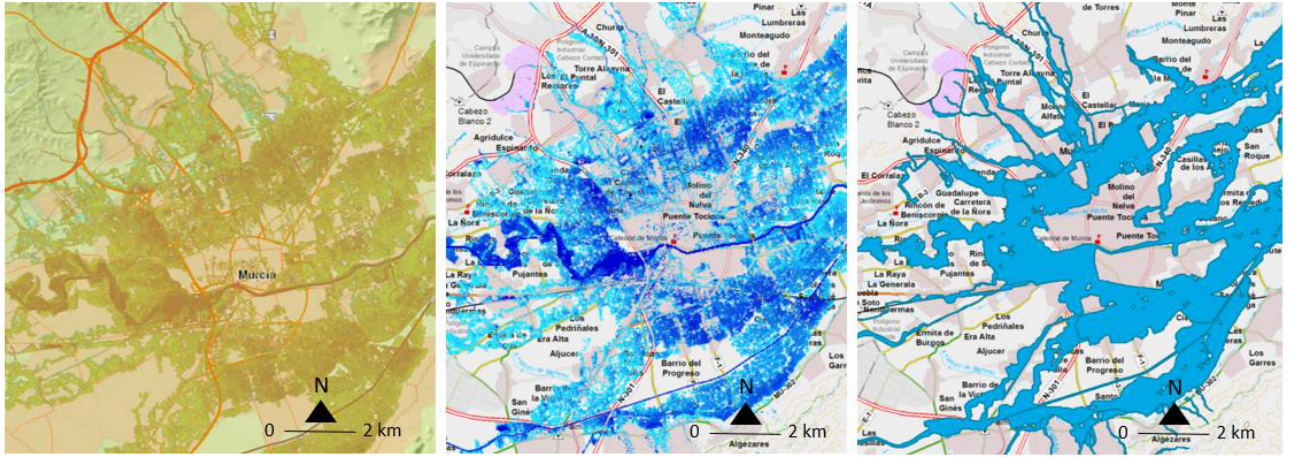
Figure 6. Implementation of spatial information on flood-prone areas: terrain elevation model incorporating orographic conditions in areas at risk of flooding (upper left), map of flood-prone areas with risk for the population in urban areas (upper right), map depths (bottom left) and preferential flow areas where the water flow only acquires greater speed (bottom right).